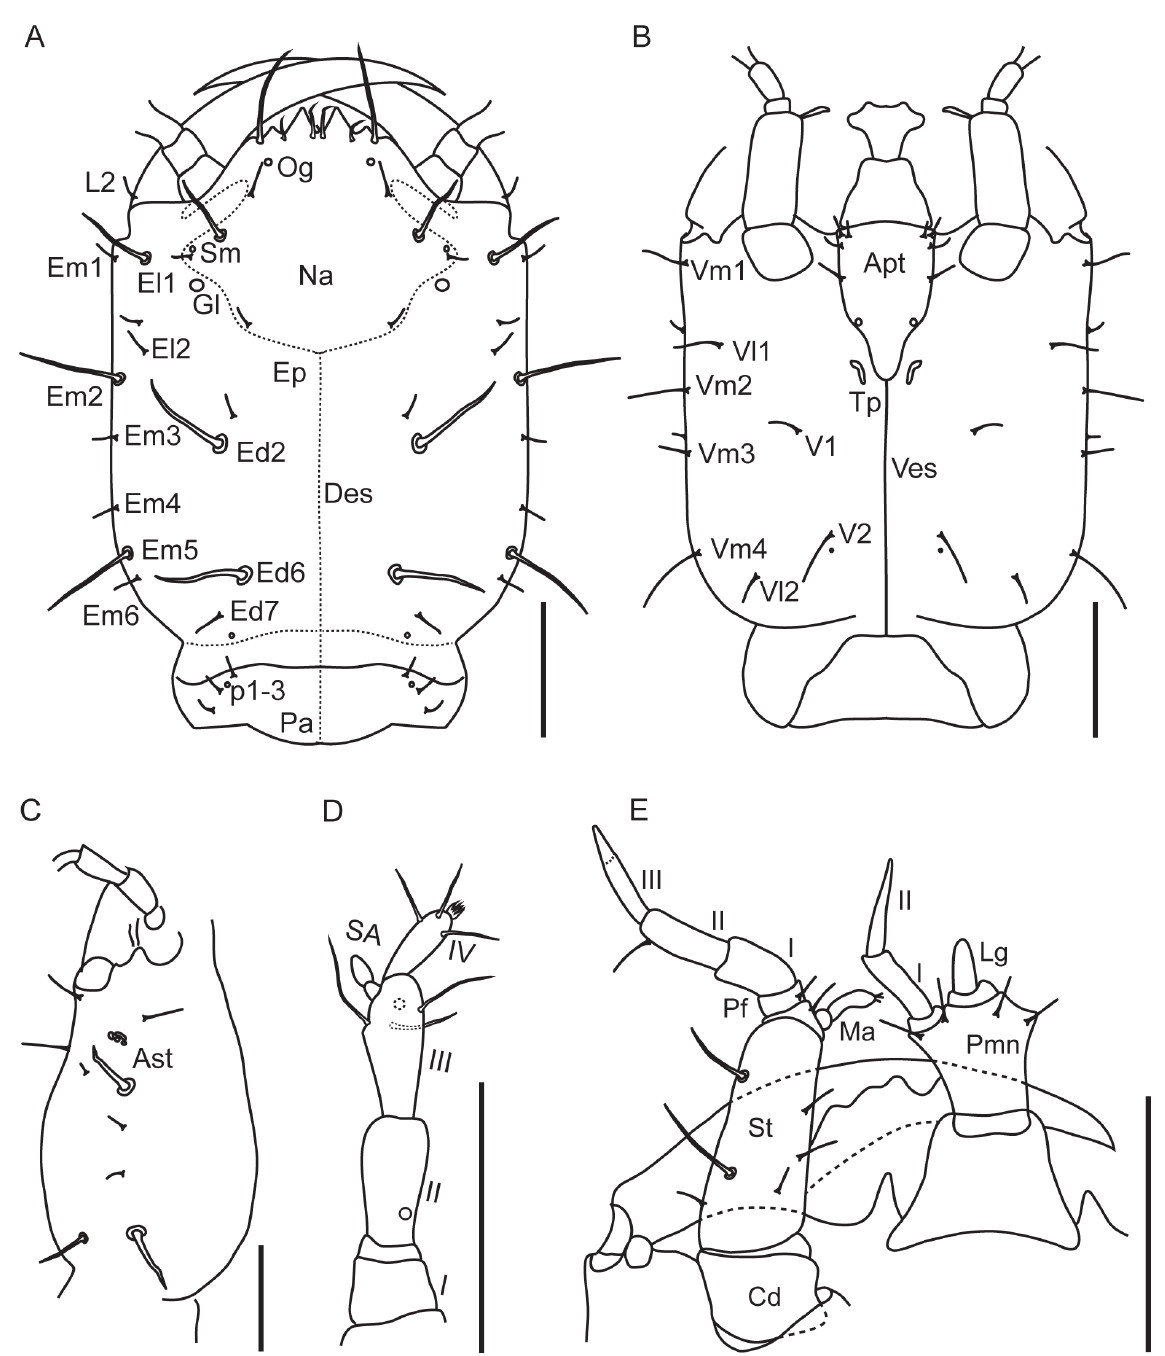
Fig. 6. Quedius masuzoi Watanabe, 1989. Morphology of larva: head. A . Head capsule, dorsal view. B . Head capsule, ventral view. C . Head capsule, lateral view. D . Antenna, dorsal view. E . Maxilla and labium, ventral view. Abbreviations: Apt = apotome; Ast = stemmata; Cd = cardo; Des = dorsal ecdysial line; Ed = epicranial dorsal seta; El = epicranial lateral seta; Em = epicranial marginal seta; Ep = epicranial part; Gl = epicranial gland; L = lateral seta; Lg = ligula; Ma = mala; Na = nasale; Og = olfactory organ; p = posterior seta; Pa = posterior area; Pf = palpifer; Pmn = prementum; Sa = sensory appendage; Sm = sensilla; St = stipes; Tp = tentorial pit; V = ventral seta; Ves = ventral ecdysial line; Vl = ventral lateral seta; Vm = ventral medial seta; I–IV = segment enumeration. Scale bars = 0.5